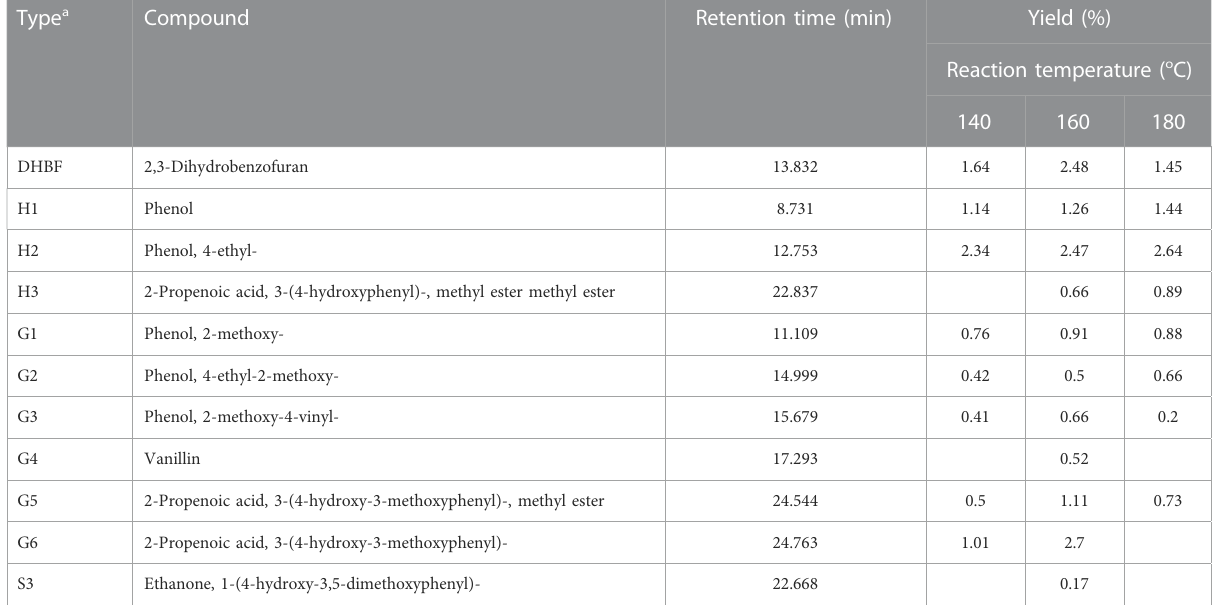
TABLE 4 Effect of reaction temperature on the distribution of lignin-derived aromatic monomers.